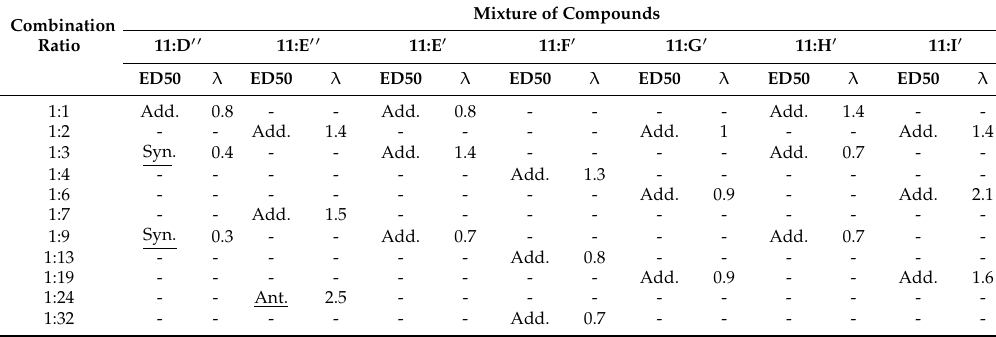
Table 5. Types of interactions with Student’s t test ( α = 0.1) and interaction index ( λ ) between the different combinations of anethole ( 11 ) and active fractions (D 11 and E 11 ) from the acetone extract and (E 1 –I 1 ) from the DCM extract. (Add.: additive; Syn.: synergistic; Ant.: